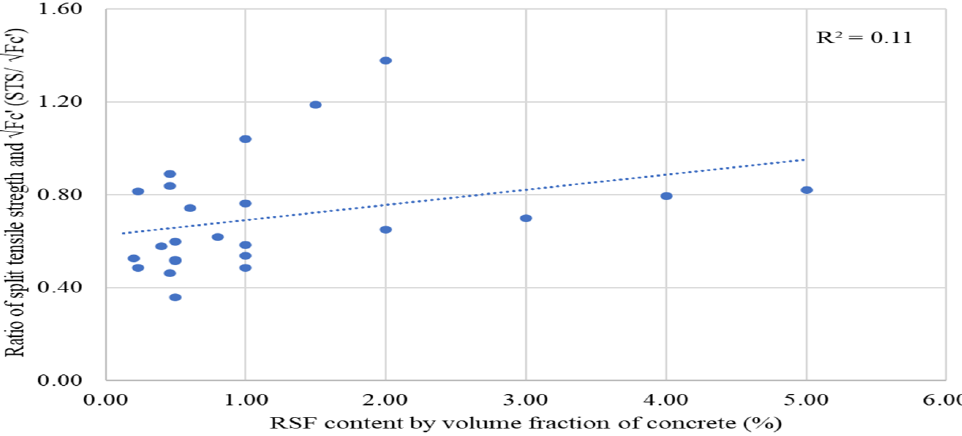
Figure 20. Effect of RSF (0% to 5%) on the ratio between compressive strength and split tensile strength.